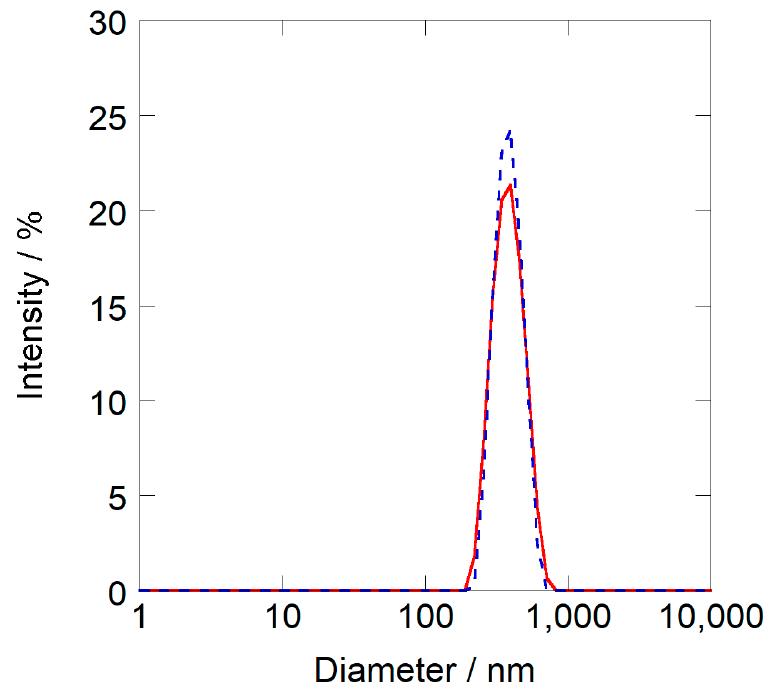
Figure 3. Size distribution of PNIPAM nanoparticles (measured by dynamic light scattering study) in water-methanol binary solvent: red line ( X M = 0.20); black dotted line ( X M = 0.3).